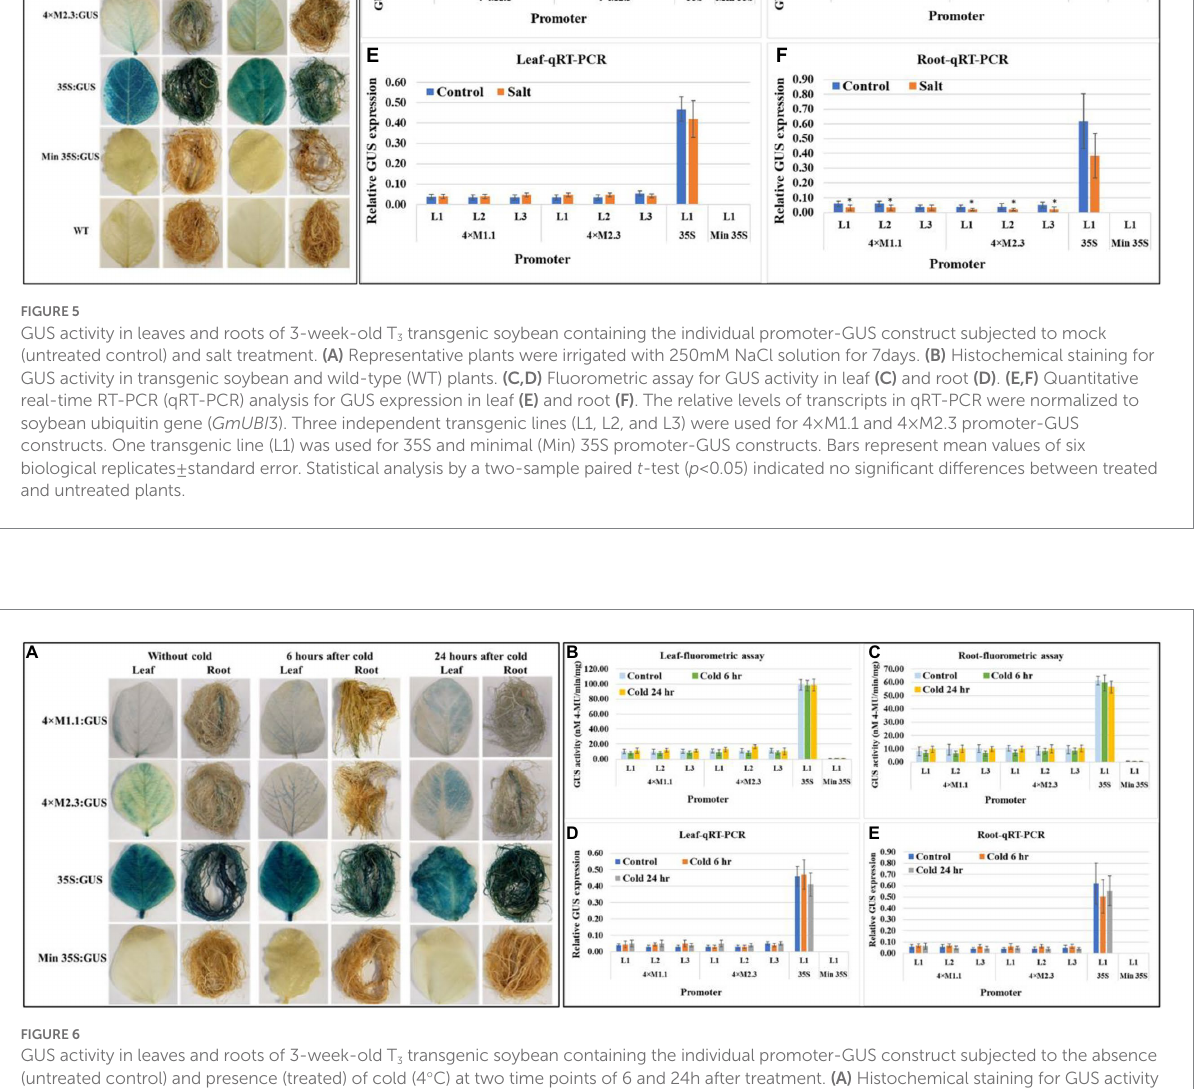
of treatment (Supplementary Figure S5A). In roots, very weak GUS staining was observed under each synthetic promoter after 24 h of ABA treatment (Supplementary Figure S5A). Fluorometric GUS assay showed stronger GUS activity in the leaves with an average of 1.8-fold higher under the control of